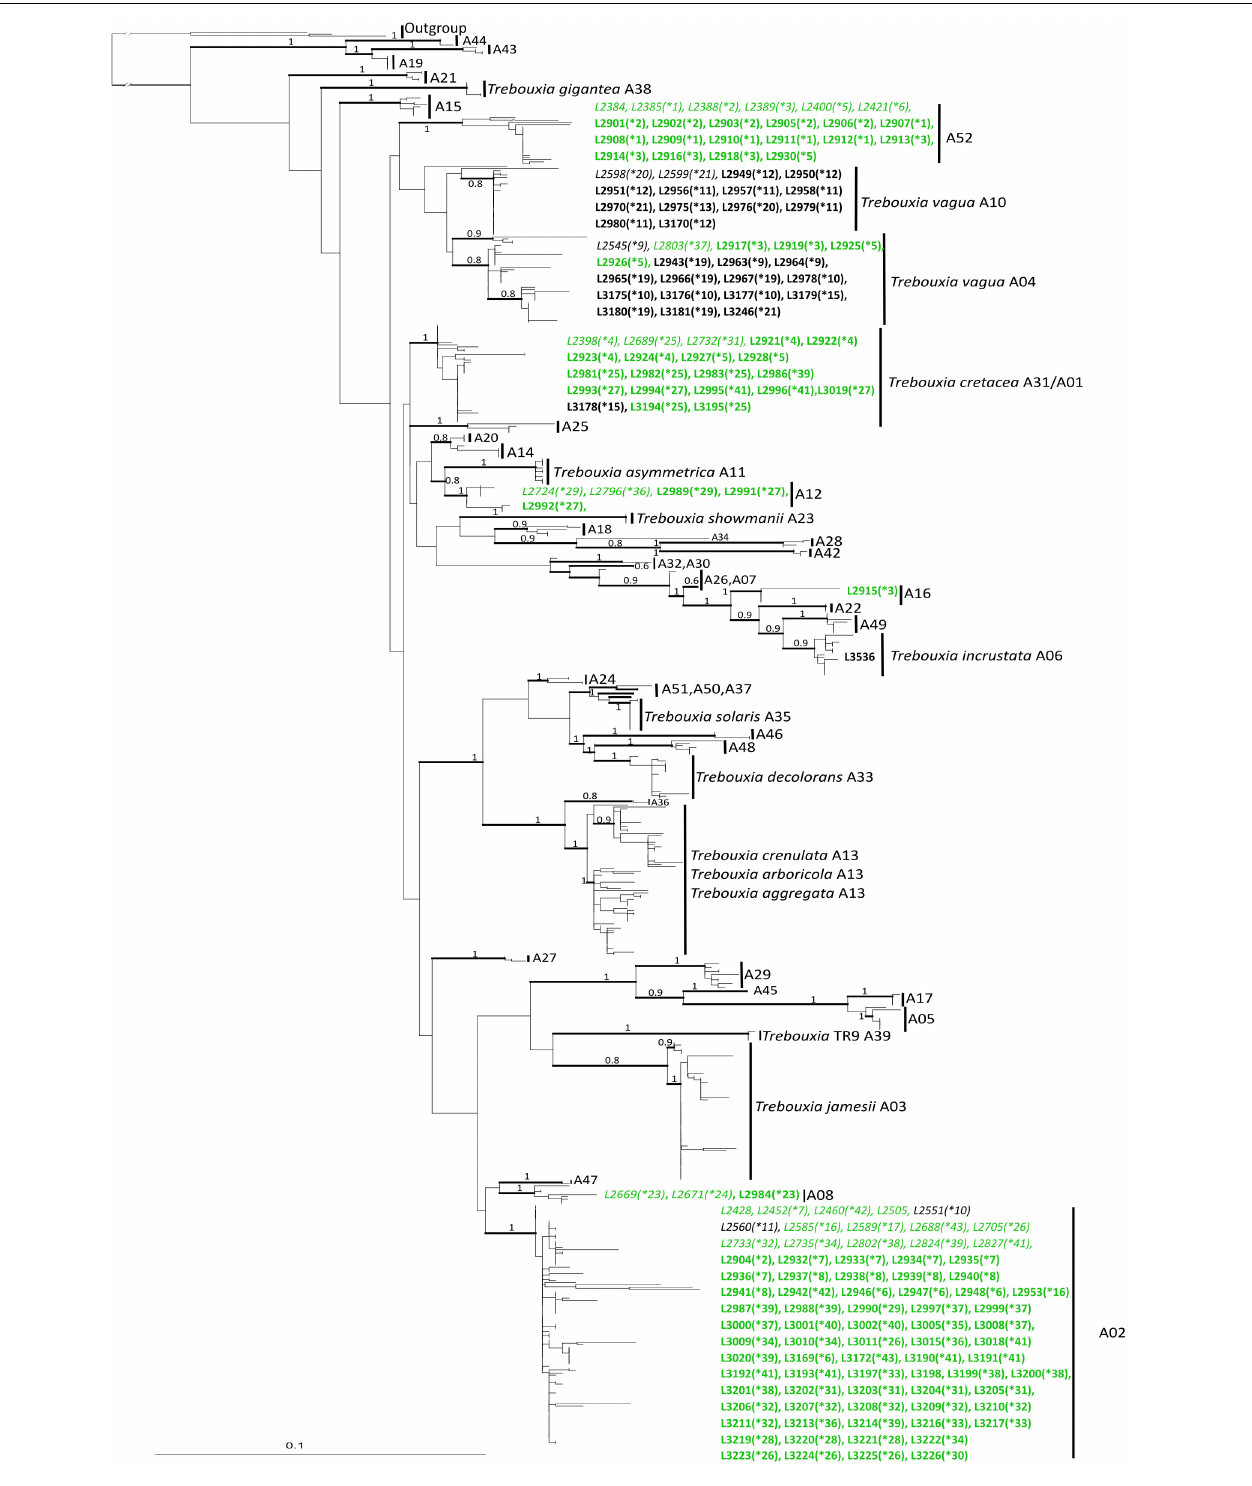
FIGURE 2 | Phylogenetic hypothesis based on the ITS locus of Trebouxia Clade “A”: the 50% majority rule consensus tree of the Bayesian analysis is presented; ML bootstrap values higher than 70% are reported with bold branches; Bayesian PP values > 0.8 are reported above branches. DNA extraction numbers of the new Trebouxia sequences coming from the original lichen thalli are in italics , while those obtained from the cultured strains are in bold. Correspondence between the original lichen thallus and the axenically isolated Trebouxia strains is indicated by an asterisk and a number in parenthesis ( ∗ 1–64; as in Supplementary Table 2 ). Sequences coming from either lichen species are color coded: green for Rhizoplaca melanophthalma and black for Tephromela atra .